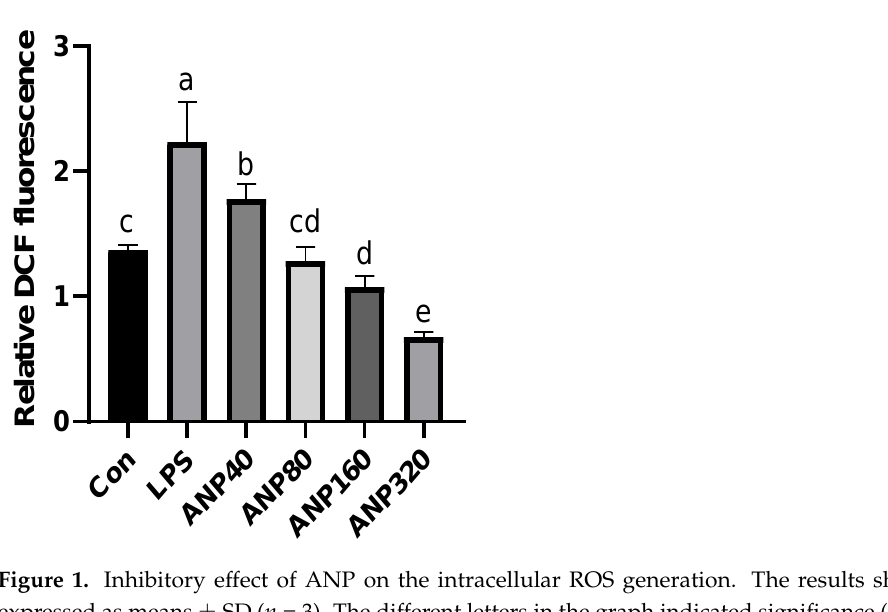
vealed that ANP could reduce intracellular ROS levels induced by LPS.